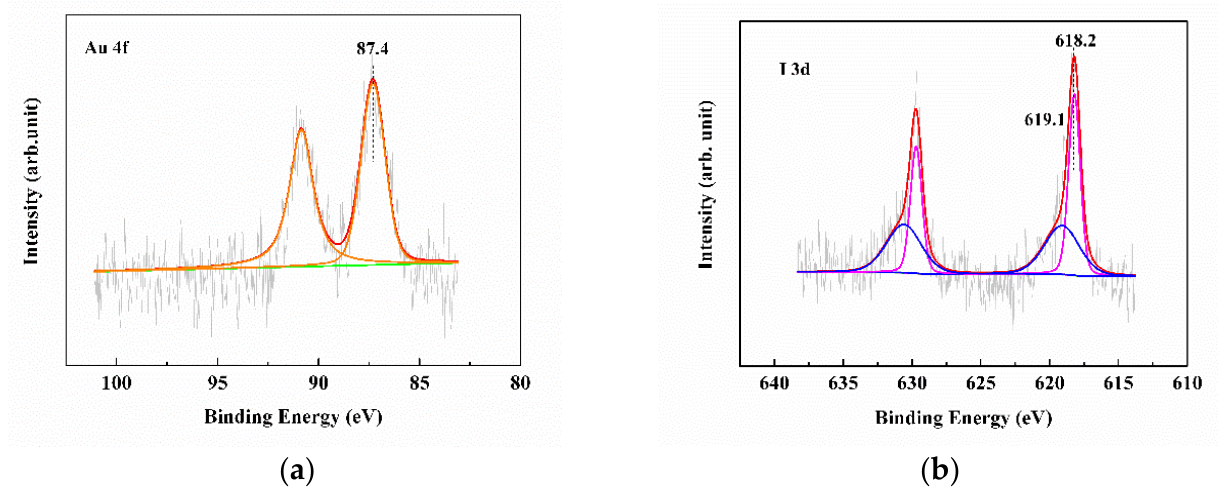
Figure 7. XPS spectrum of Au 0 dissolved in ionic liquid system under lighting condition: ( a ) Au 4f, ( b ) I 3d.